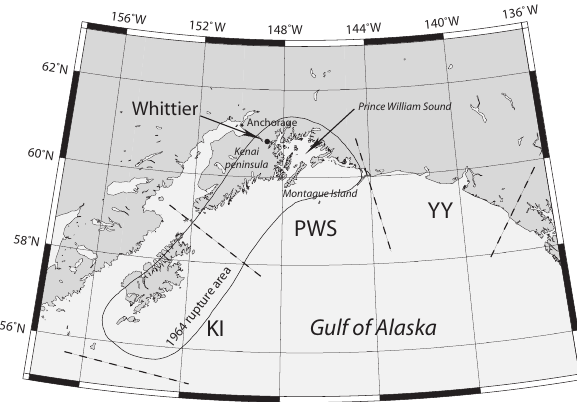
(cid:237)(cid:20)(cid:24)(cid:19)(cid:237)(cid:20)(cid:19)(cid:19)(cid:237)(cid:24)(cid:19)(cid:19)(cid:24)(cid:19)(cid:20)(cid:19)(cid:19) (cid:25)(cid:19) ° (cid:3)(cid:23)(cid:25) ’ (cid:3)(cid:22)(cid:19) ’’ (cid:237)(cid:21)(cid:19)(cid:19) (cid:237)(cid:20)(cid:23)(cid:27) ° (cid:23)(cid:19) ’ Fig. 2. (A) A drawing of the Passage Canal coastline and locations of major glacial creeks flowing into the canal. The city of Whittier is located on the southern coast of Passage Canal within an area outlined by a red rectangle. The red arrow shows a direction of the 8.2m land displacement during the 1964 earthquake (Kachadoorian, 1965). (B) Digitally edited 15-m resolution DEM of the region shown within the red rectangle. The elevation is in meters above the pre-earthquake MLLW level. The dashed yellow line represent the shoreline just before the earthquake. Two black contour lines mark 5 and 10m elevations above the MLLW level. The present day wave breaker and cruise ship terminal are removed from the DEM to model the 1964 bathymetry and topography. The green lines show locations of along which the bathymetry was measured before and after the 1964 earthquake (Plate 3, Kachadoorian, 1965). Yellow rectangles marked by letters a), b) and c) show locations of the airport, harbor facilities, and the railroad depot, respectively. Red-yellow rectangles, marked by numbers 1–5, show locations at which the modeled wave height is compared to eyewitness